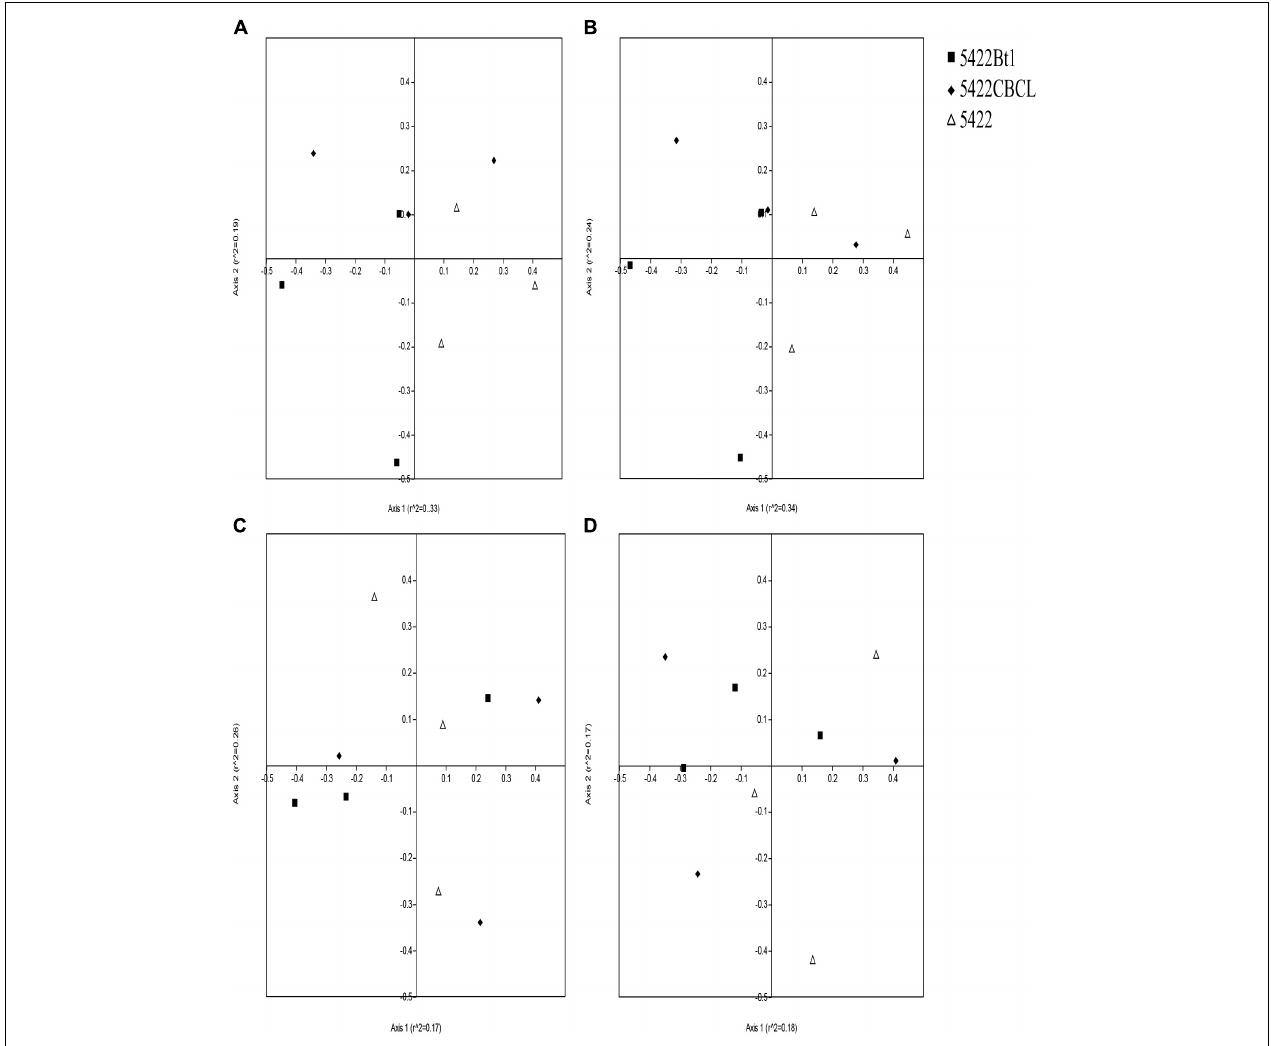
FIGURE 5 | Non-metric multidimensional scaling (NMDS) ordination plots of the AM fungal communities in roots (A,C) and rhizosphere soils (B,D) associated with Bt and non-Bt maize varieties cultivated for five consecutive season (A,B) or straw returning to subsequent conventional maize variety (C,D)